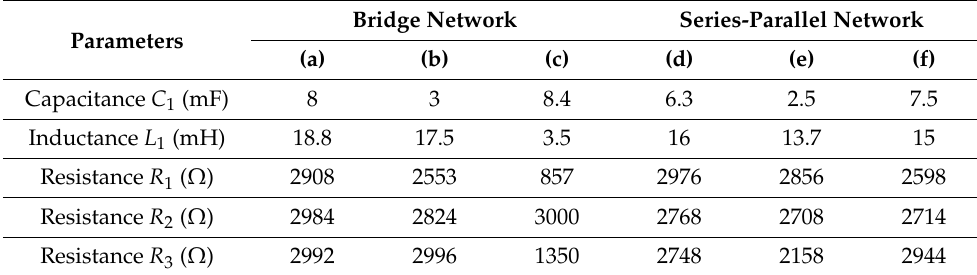
Table 2. Optimized parameters of the electrical